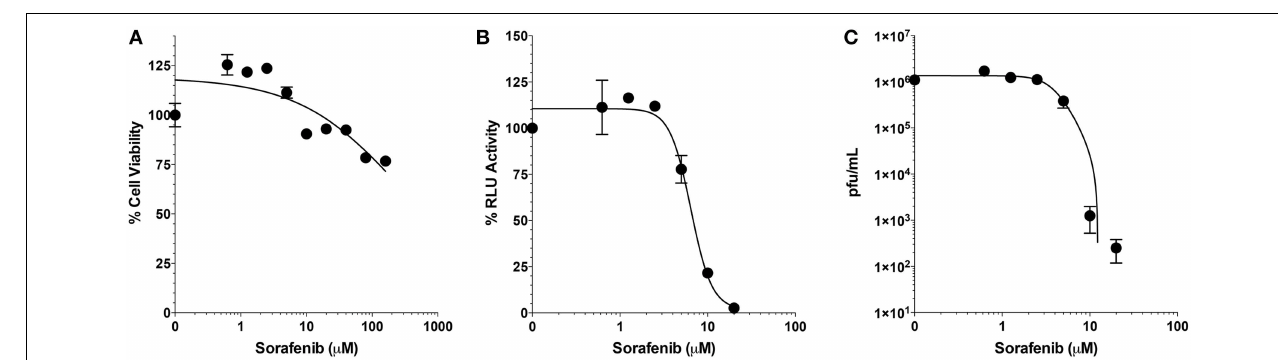
FIGURE 3 | Selective index of Sorafenib. (A) Serial 2-fold dilutions (160, 80, 40, 20, 10, 5, 2.5, 1.25, and 0.625 µ M) of Sorafenib were used for treatment of Vero cells. After 24h, cell viability was assessed and plotted as percentage of the control, DMSO alone. Mean and standard deviations are plotted from three biological replicates. Non-linear regression stastics was applied, with the constraint that bottom of the span was to set to less than 10%, to determine the CC 50 . (B,C) Serial 2-fold dilutions (20, 10, 5, 2.5, 1.25, and 0.625 µ M) of sorafenib were used for treatment of Vero cells